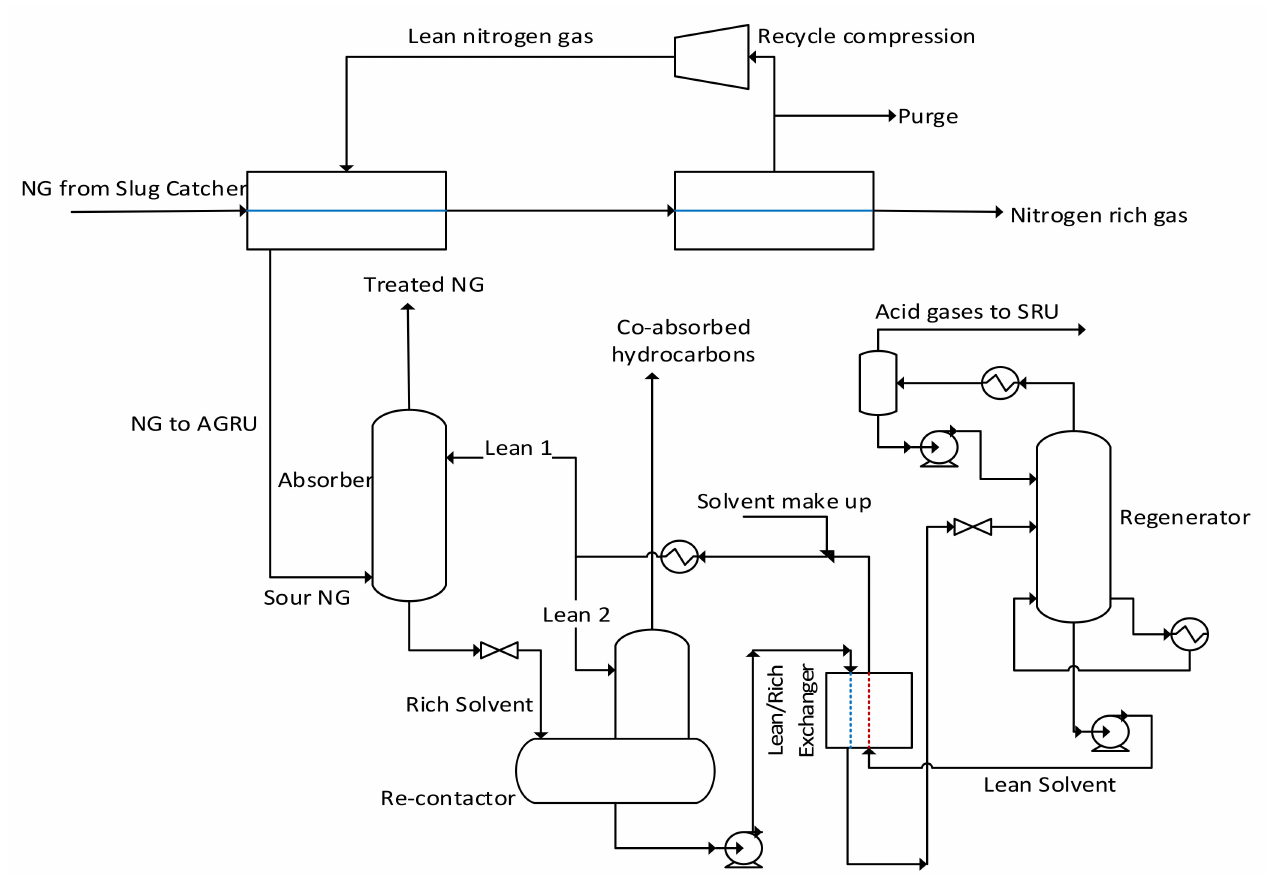
Figure 3. Proposed upfront N 2 removal upstream of the AGR using membrane